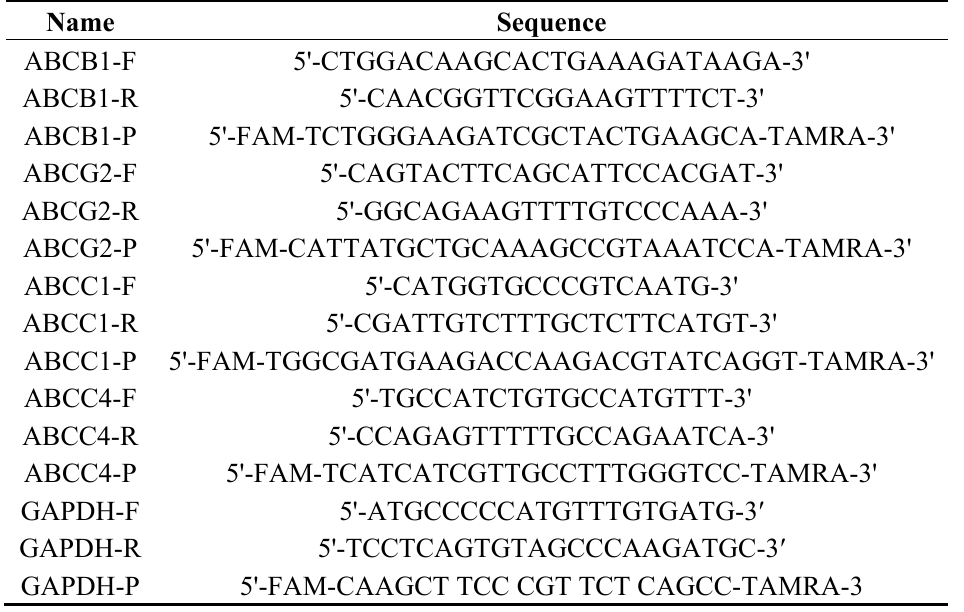
Table 2. The primers and probes sequence for quantitative real-time